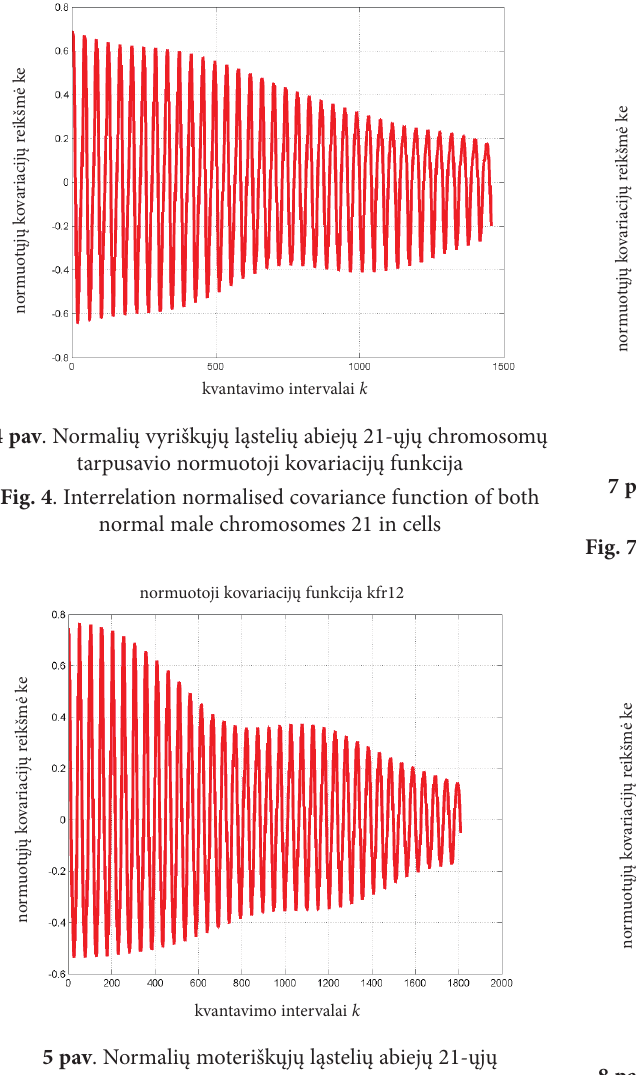
8 pav . Patologinių moteriškųjų ląstelių priedinės (trečiosios) 21-osios chromosomos normuotoji kovariacijų funkcija Fig. 8 . Normalised covariance function of the abnormal female extra (third) chromosome 21 in